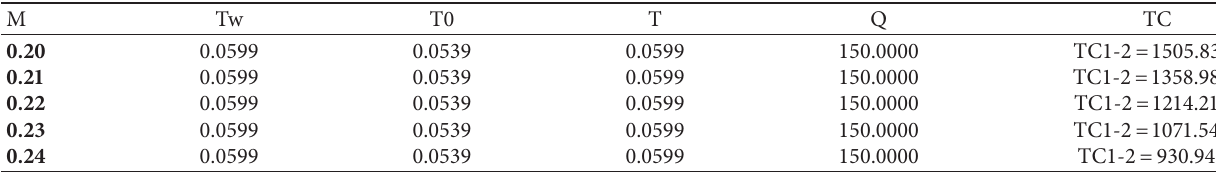
Table 5: The obtained solutions under different values of M.